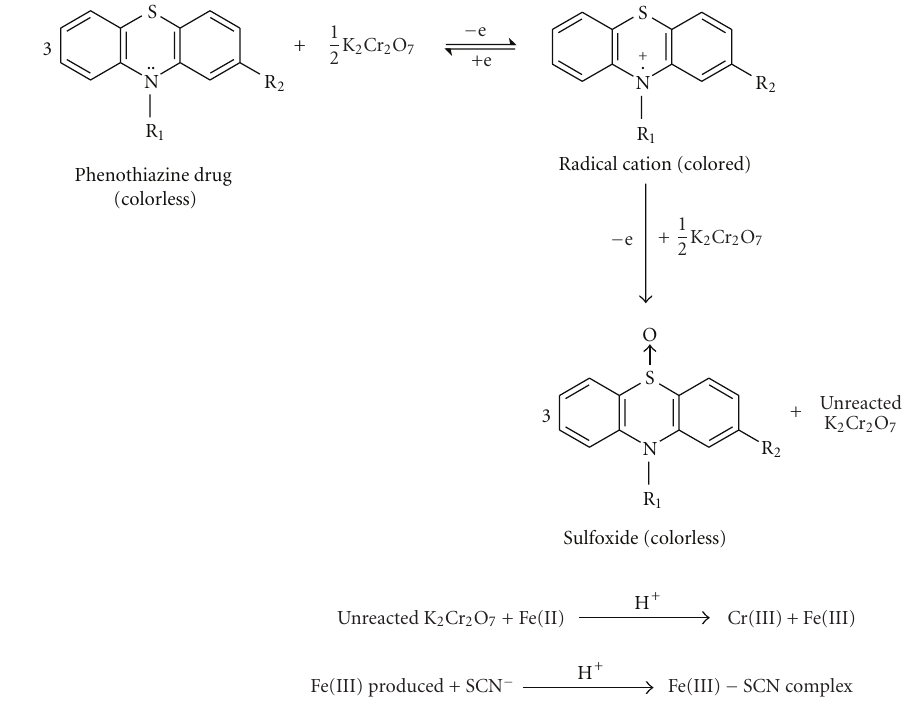
Scheme 2: Reaction scheme showing the formation of iron(III)-thiocyanate complex and correlation of the latter’s concentration with phenothiazine drugs concentration.